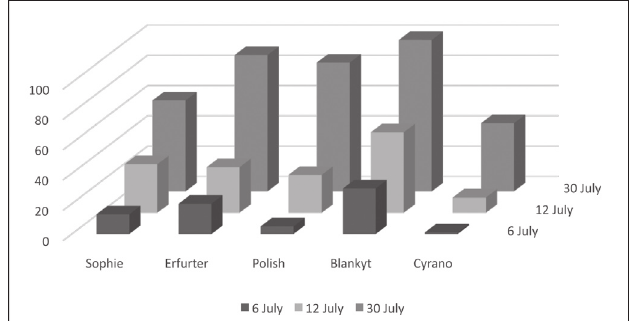
Fig. 1: Proportion of flowering individuals of one-year old hyssop acces - sions at different observation times